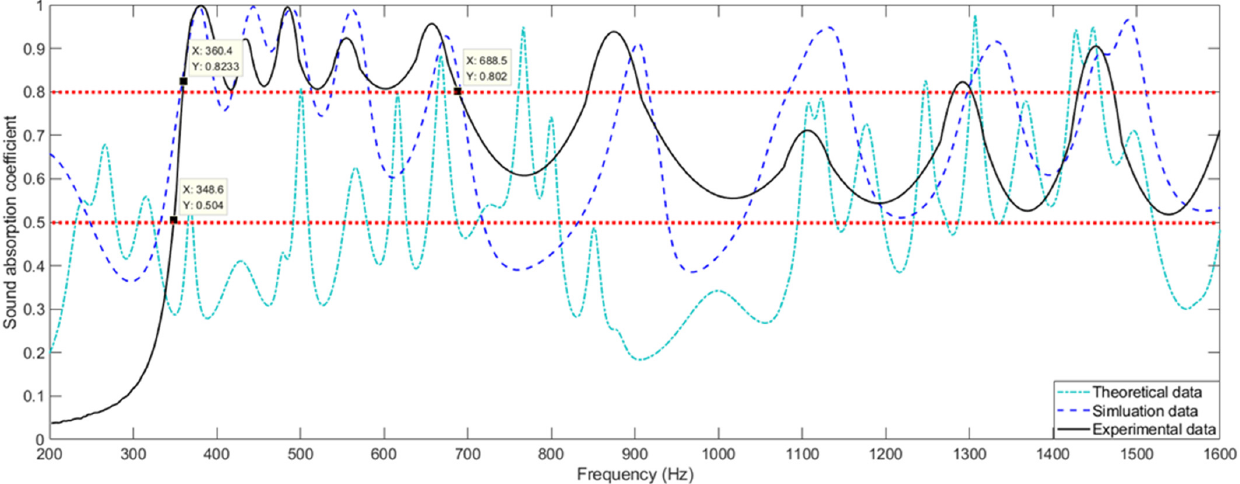
Figure 7. Comparisons of the actual sound absorption coefficients of the MSC-AM with those in theory and those in simulation.